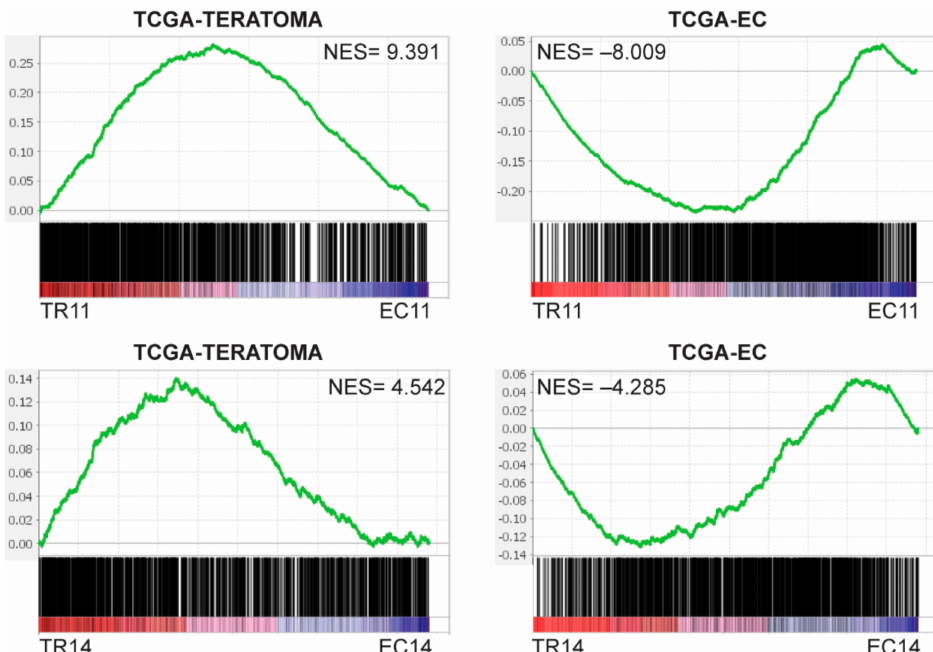
Figure 2. Murine EC cells and their thioridazine-differentiated derivatives transcriptionally resemble human EC and teratoma, respectively. Gene sets were created by comparing RNASeq data from The Cancer Genome Atlas (TCGA) for 17 pure embryonal carcinomas and 3 teratomas. TCGA-EC includes genes significantly upregulated (FDR < 0.05) in the embryonal carcinomas, and TCGA- TERATOMA includes genes significantly upregulated in the teratomas. Preranked gene lists were created comparing each murine EC cell line to its thioridazine-differentiated derivative. Gene Set Enrichment Analysis (GSEA) enrichment plots indicate that genes that are upregulated in human pure embryonal carcinomas (TCGA-EC) were overrepresented in murine EC cells, and genes that are upregulated in human pure teratomas (TCGA-TERATOMA) were overrepresented in the thioridazine- differentiated cells. NES = normalized enrichment score. FDR < 0.001 for all enrichment